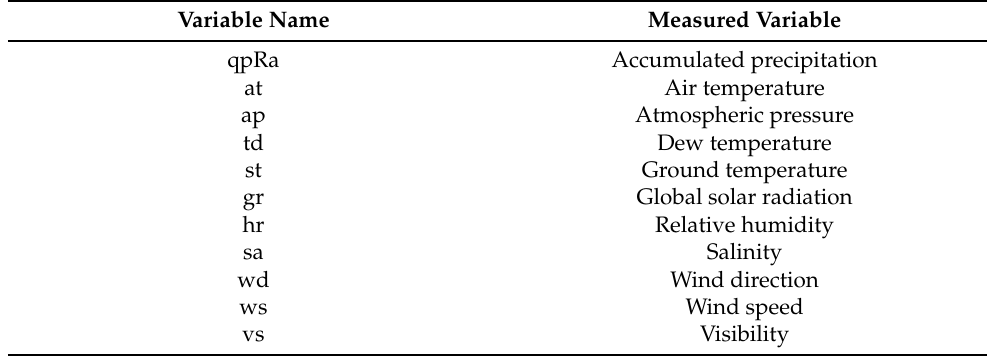
Figure 8. Correlation matrix between target and predictive variables for each time prediction horizon. Table 1. Predictive variables measured at Mondoñedo, Galicia,